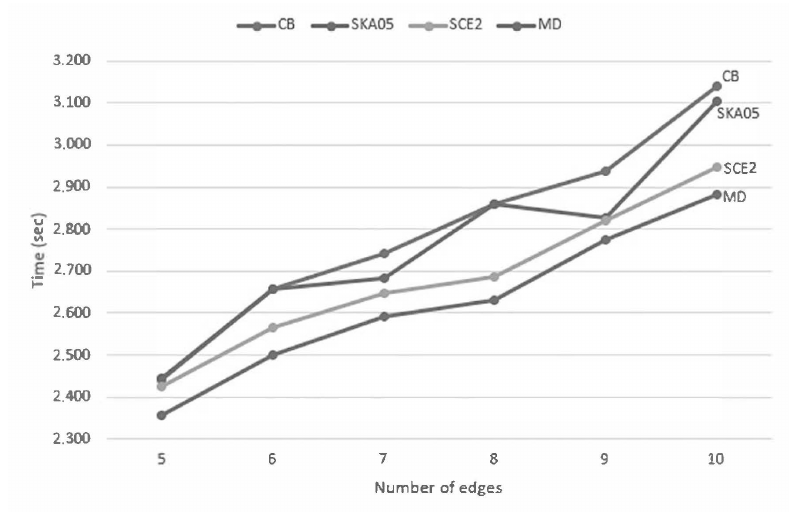
Figure 45. Speed graph of each algorithm when clipping 10 million lines against convex polygons with different number of edges (lower is better).